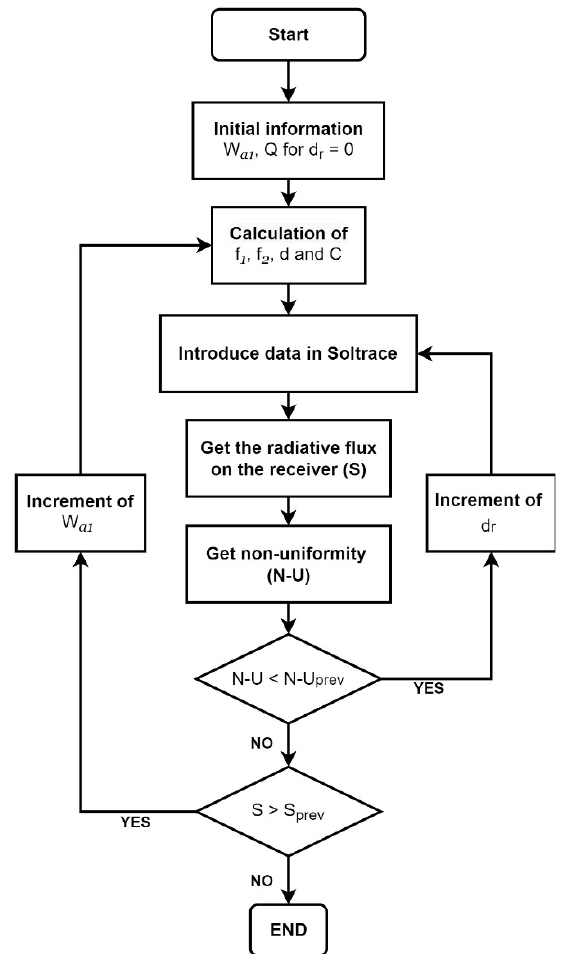
Figure 3. Flowchart of the radiative flux and the non-uniformity calculation.